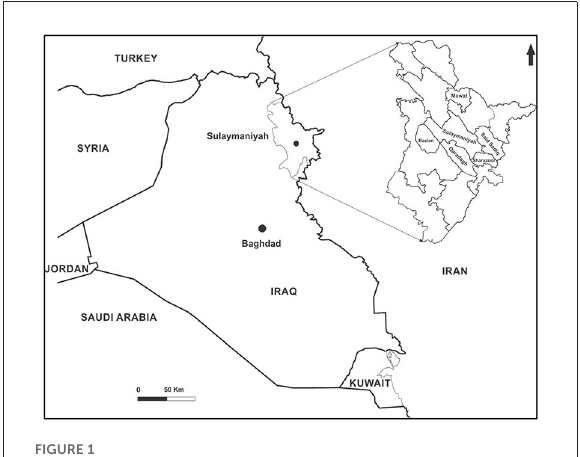
FIGURE1 Iraqi map showing the study areas in